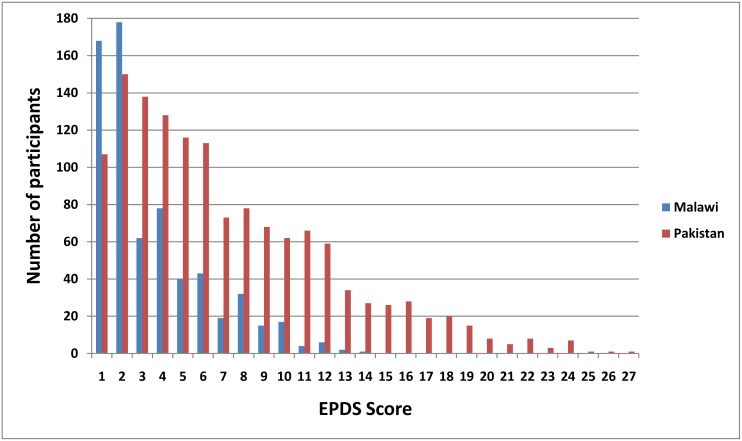
Distribution of EPDS scores for rural women in Malawi and Pakistan.